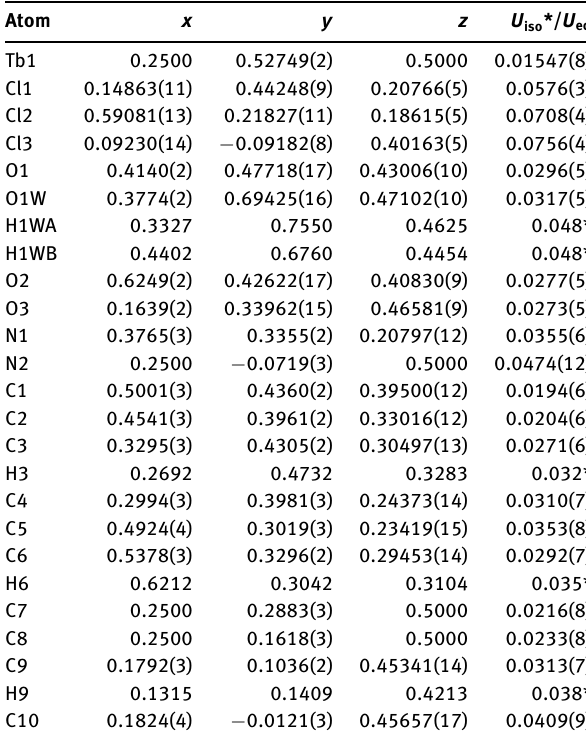
Table 2: Fractional atomic coordinates and isotropic or equivalent isotropic displacement parameters (Å 2